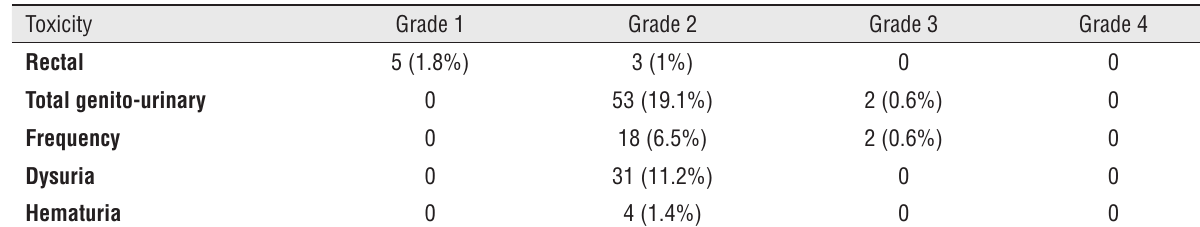
Table 6 - RTOG late genito urinary and rectal toxicity (>3 months). No grade IV toxicity was seen, only a few patients had grade III toxicity. The results are comparable with other